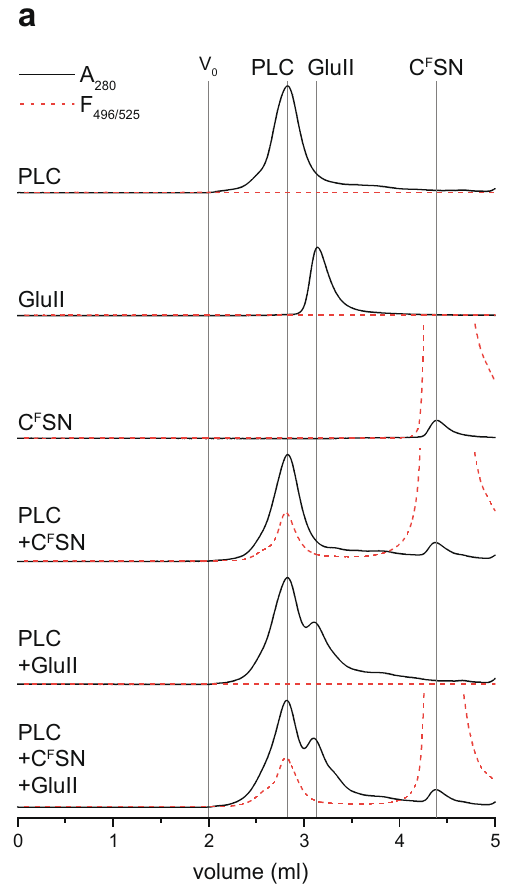
Fig.4 |PLCremainsfullyassembledafterpeptideeditingandglycantrimming by GluII. a The size of the Nd-reconstituted PLC remains unchanged after peptide binding and GluII trimming as demonstrated by SEC. Peptide loading and glycan trimming by GluII does not change the overall composition and stoichiometry of thePLC. b , c ThePLCremainsfullyassembledafterMHCIloadingwithhigh-af fi nity